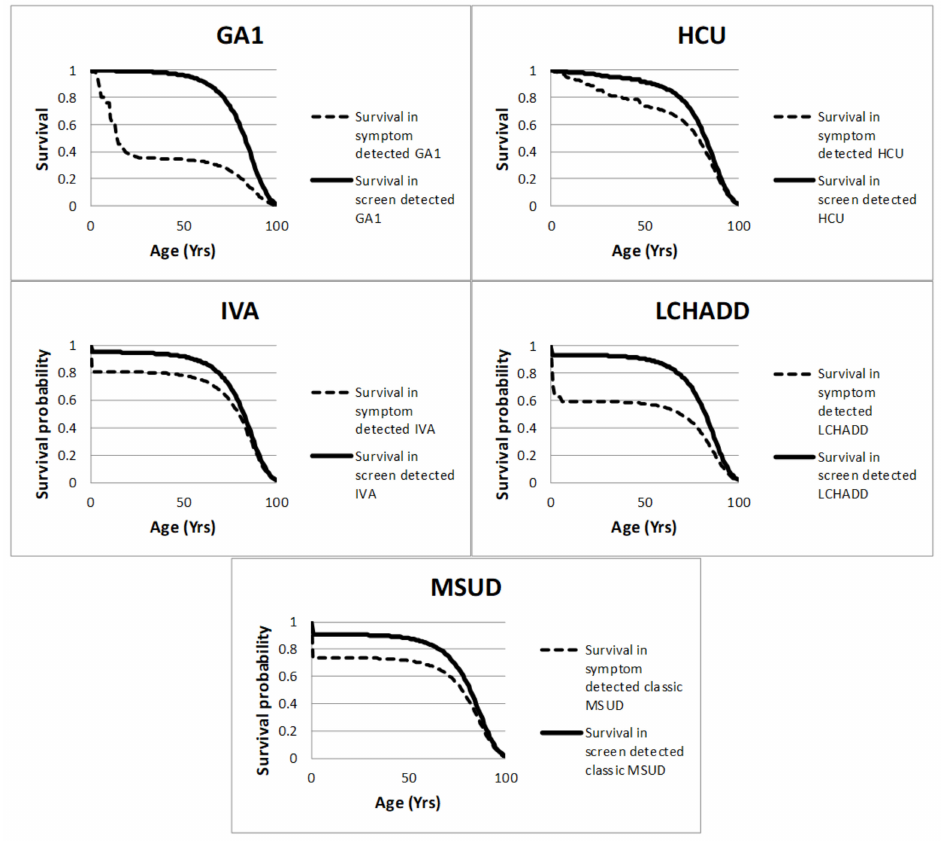
Figure 2. Modelled survival estimates in the screened and non-screened cohorts. This figure shows the modelled survival estimates for symptomatically and screen-detected cases against age for each of the five